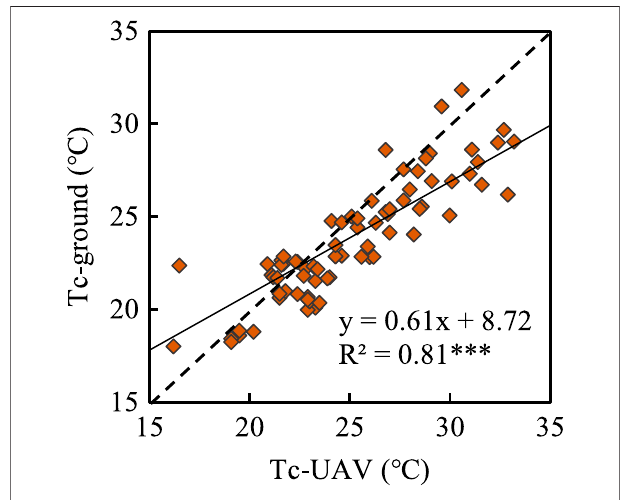
FIGURE 10 | Linear regressions obtained between proximal monitoring and aerial imagery monitoring of the alfalfa canopy temperature. The dotted line has an intercept fi xed to 0. Each point represents the value of one observation time (and the data comes from July 26 – 29). *** represents a signi fi cance level of